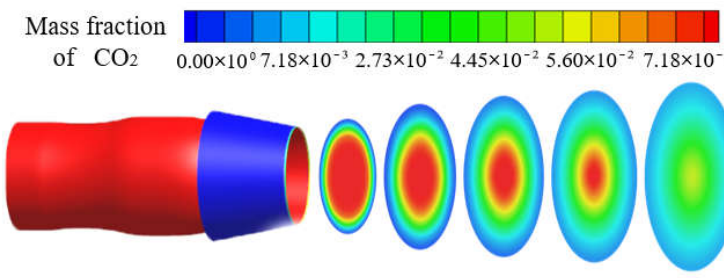
Figure 7. CO 2 mass fraction field distribution.